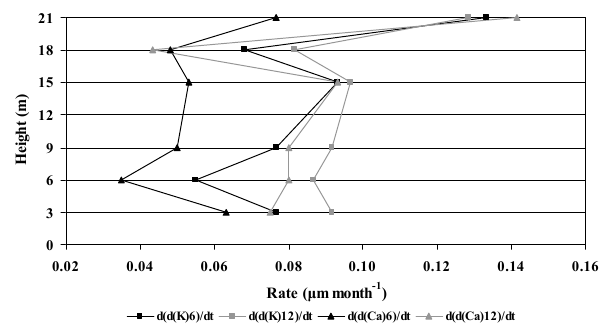
Fig. 8. Concentration of the water-soluble anions on the copper and bronze specimens exposed for one year on the main rack.